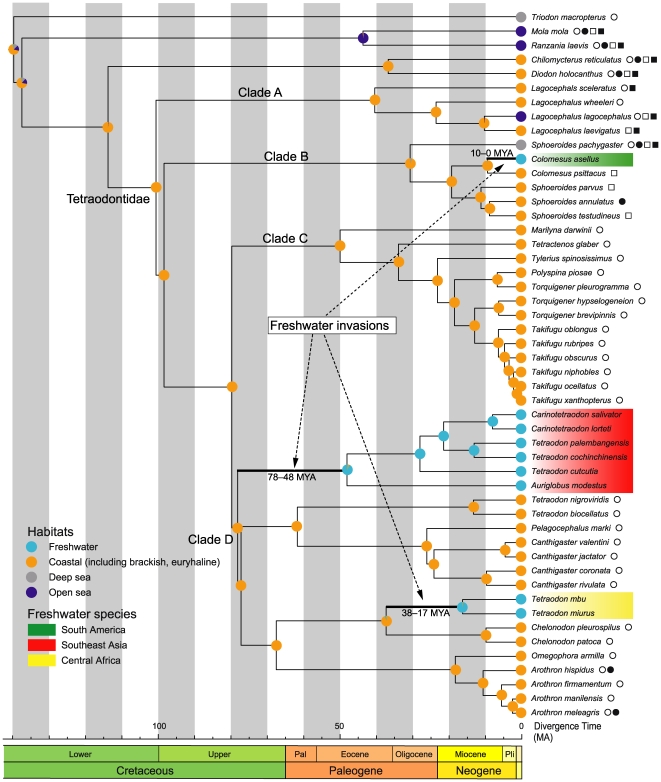
ML reconstruction of habitat types mapped onto the ML tree from the 12n3rRTn dataset.Support for each character state is indicated in each node. Branches proposed for the occurrence of freshwater invasions are bolded and numbers besides the branches indicate estimated intervals for the invasion. Open and solid circles and open and solid squares indicate species distributions in the Indo-West Pacific (including Polynesian Pacific), East Pacific, West Atlantic, and East Atlantic (including Mediterranean), respectively.